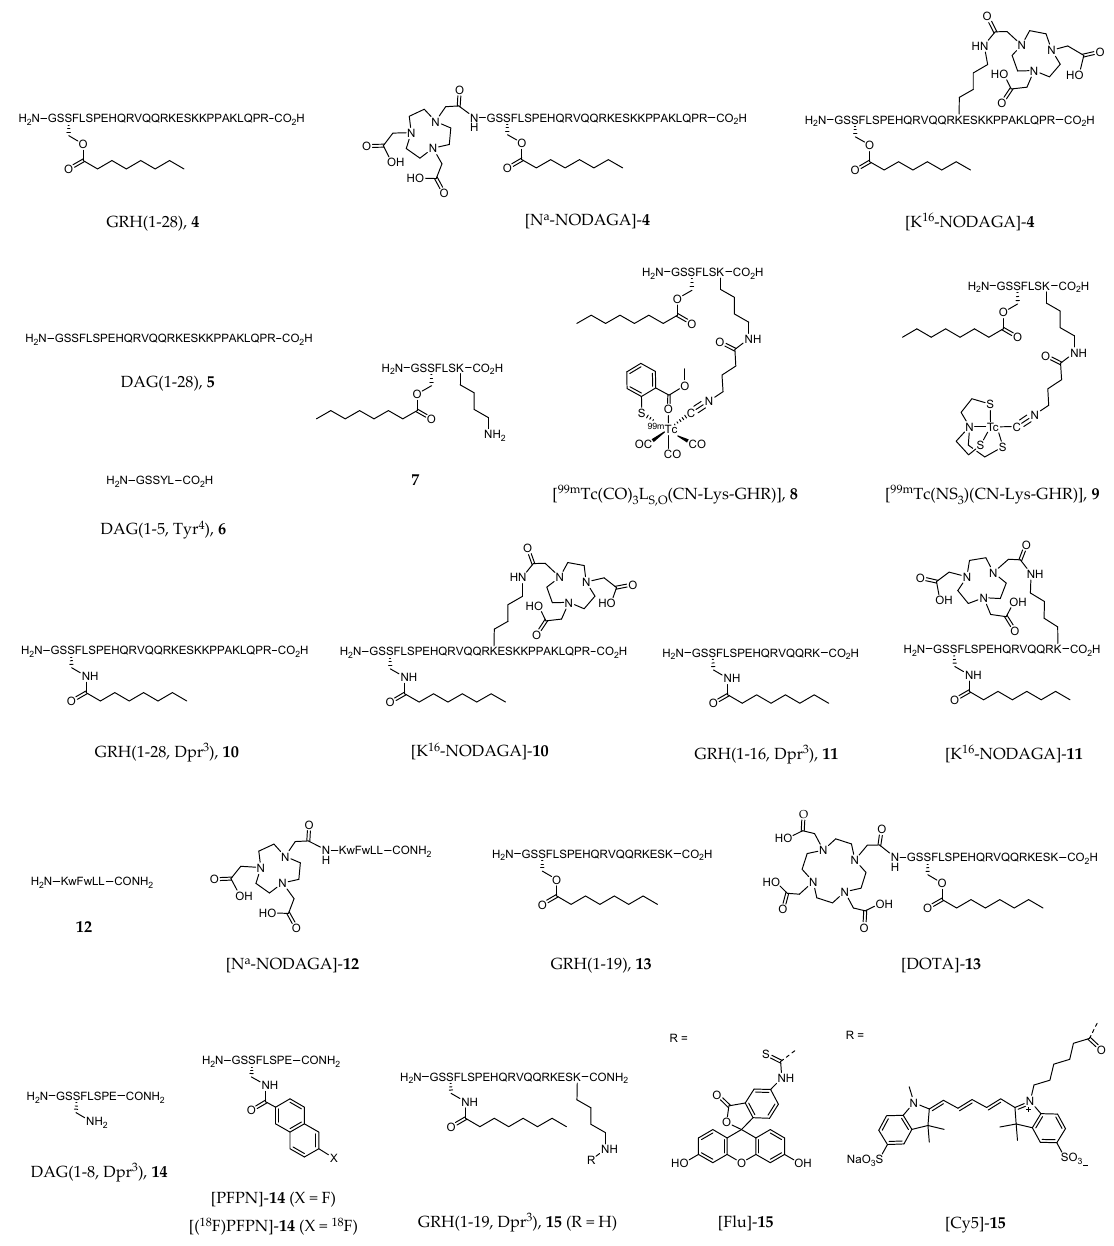
Figure 2. Human ghrelin (GRH(1–28), 4 ) and derivatives. Dpr = diaminopropionic acid; w = D -tryptophan.